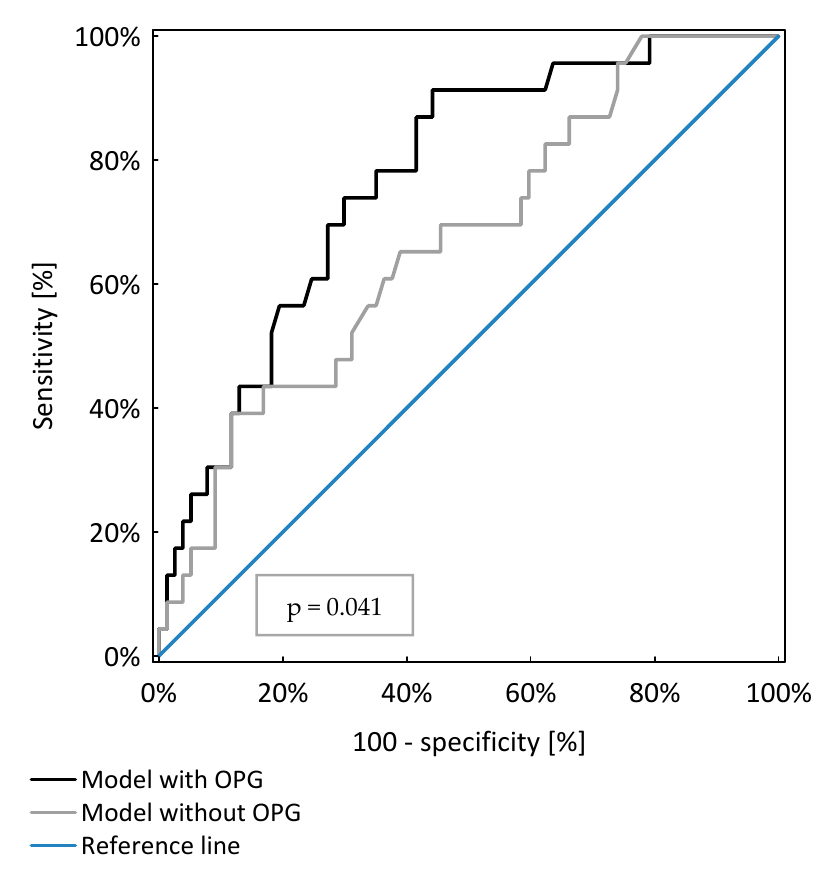
Figure 3. Comparison of two models of logistic regression analysis identifying CKD patients with protein energy wasting.